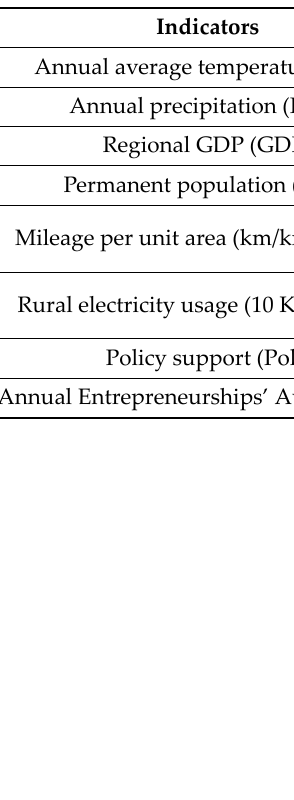
Figure 8. Conceptual framework of determinants detecting spatial context of rural entrepreneurship.